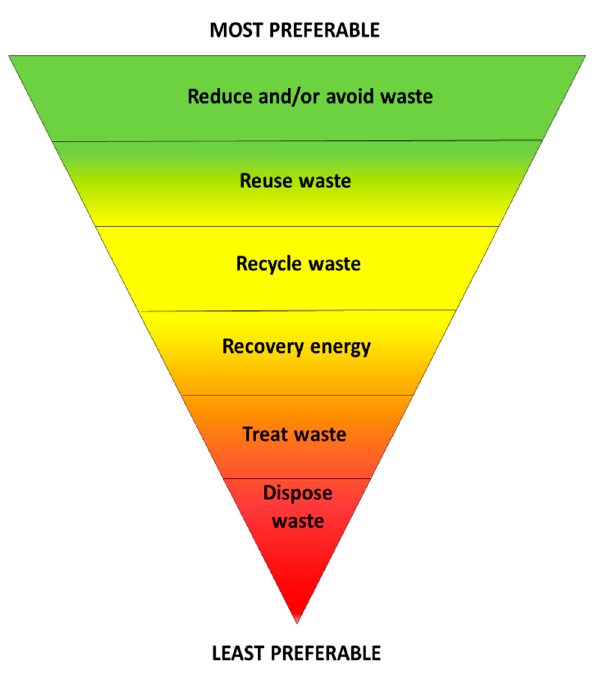
Figure 1. Scheme of the “waste hierarchy” proposed by the EPA [8].